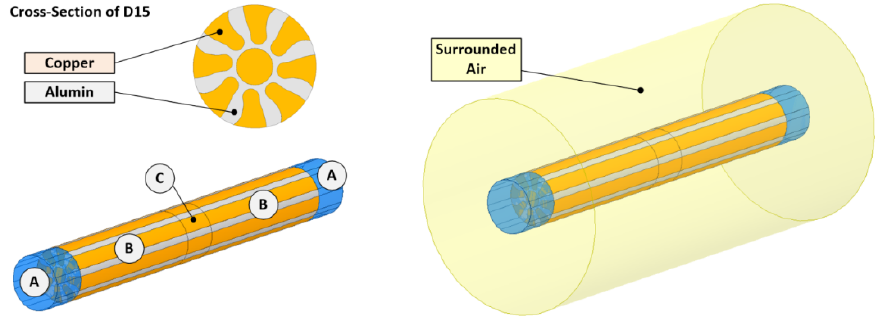
Figure 3. Model of laminated rod with individual components.